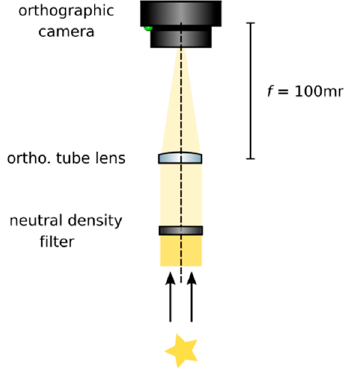
Figure 8. Building an orthographic detection. Adjust the distance between the tube lens and the camera until a sharp image of a distant object is achieved, or a collimated beam appears focused. If necessary, use a neutral intensity filter to reduce the intensity of light reaching the camera to avoid damaging it.